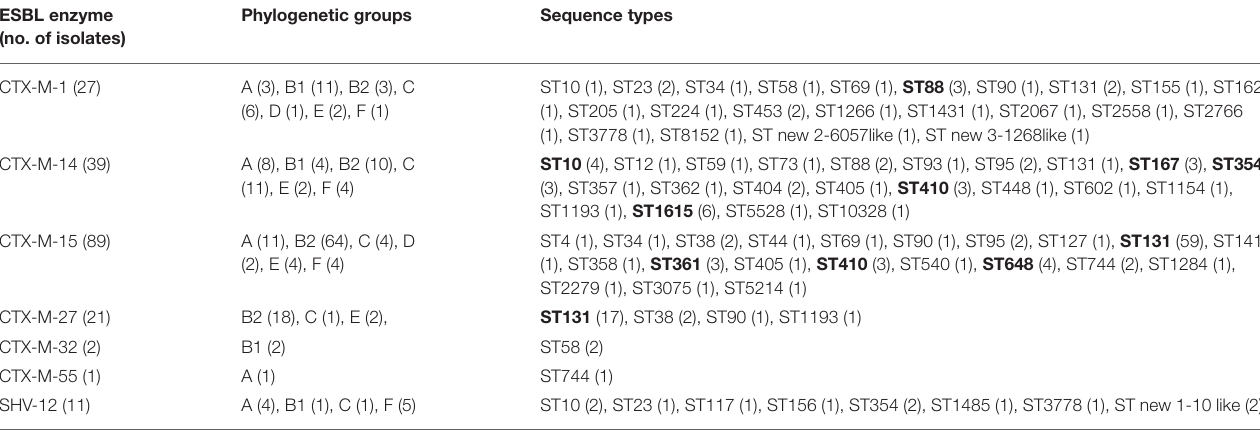
TABLE 2 | Phylogenetic groups and sequence types according to ESBL enzymes. ESBL enzyme Phylogenetic groups (no. of isolates)